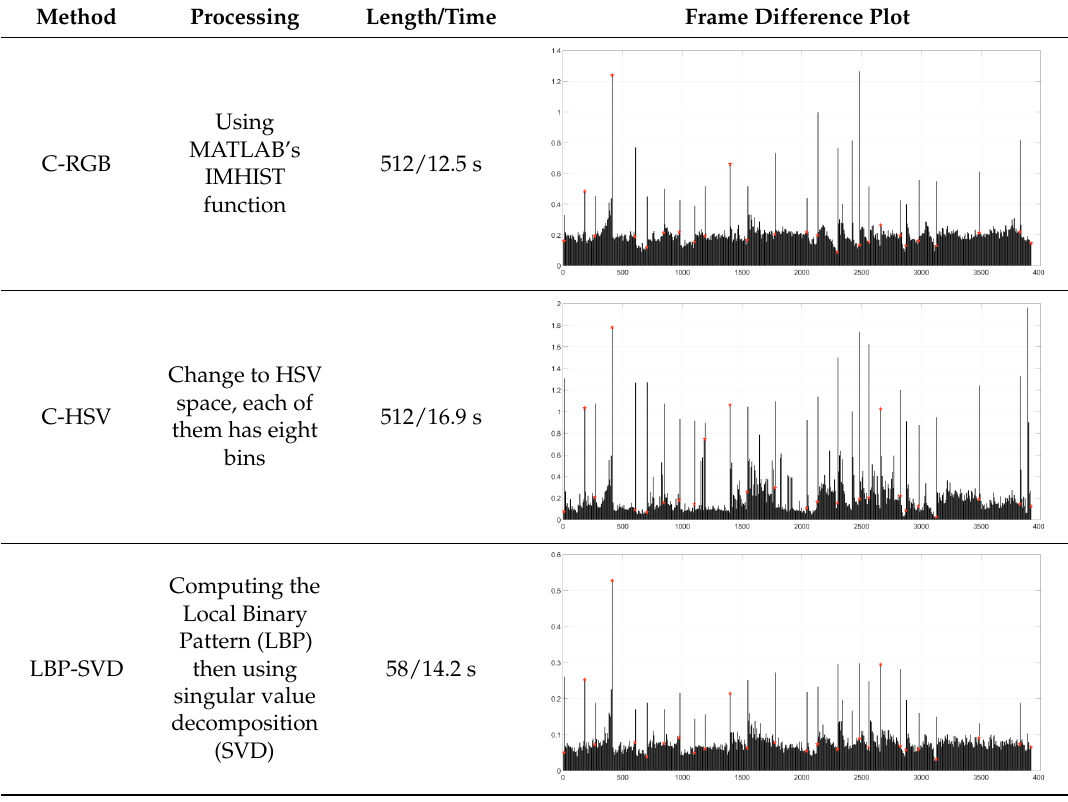
Table 4. The results of candidate segment selection by using different features on “Leon”.